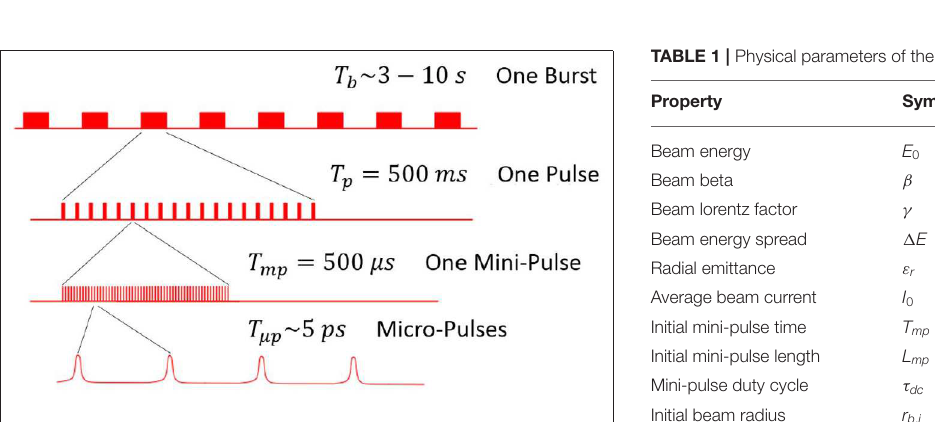
FIGURE 3 | Periodic structures and their respective typical time scales of relativistic electrons produced by a compact radio-frequency particle accelerator.